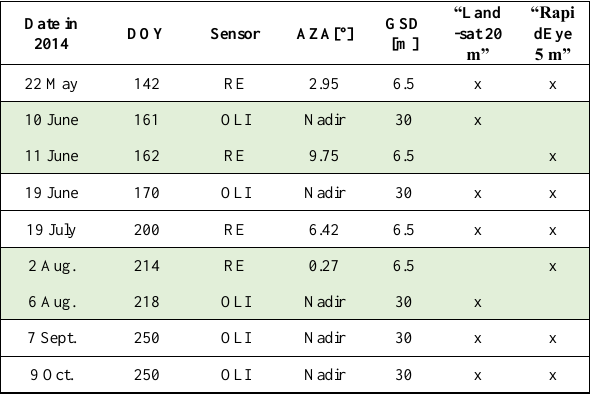
Table 2: Satellite data used for 5m and 20m yield estimation; light green indicates that these dates have been used for inter- sensor comparison (RE= RapidEye, OLI = Landsat 8 Operational Land Imager, AZA= Acquisition Zenith Angle, GSD = Ground Sampling Distance of original satellite image, DOY=Day of Year)